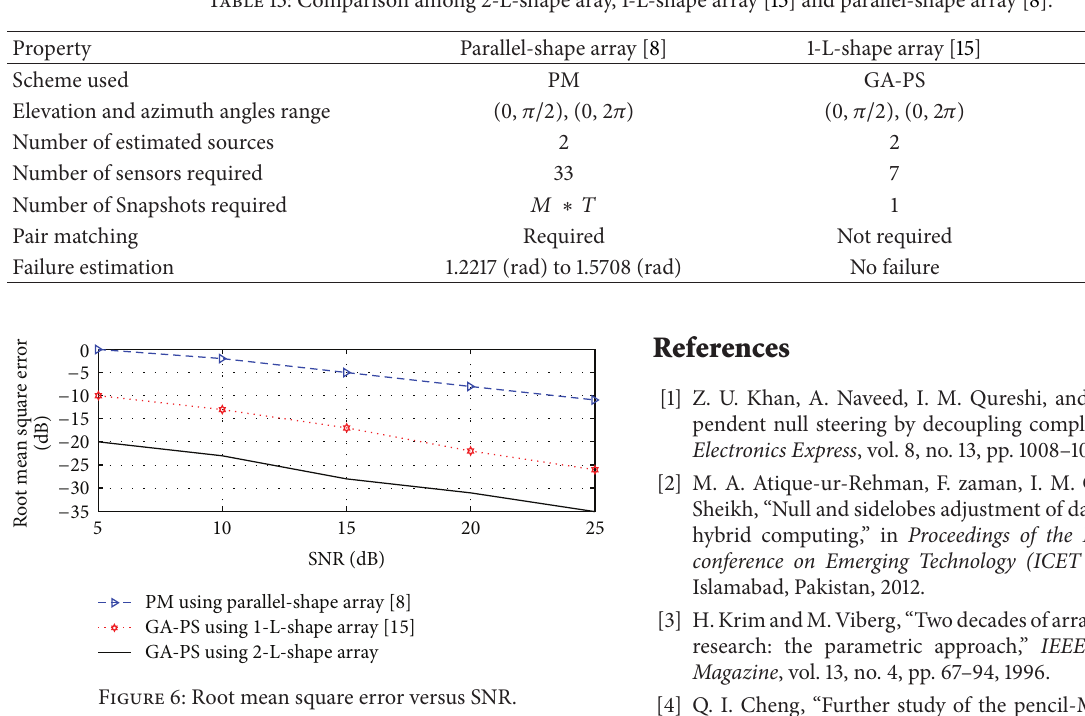
Table 13: Comparison among 2-L-shape aray, 1-L-shape array [15] and parallel-shape array [8].